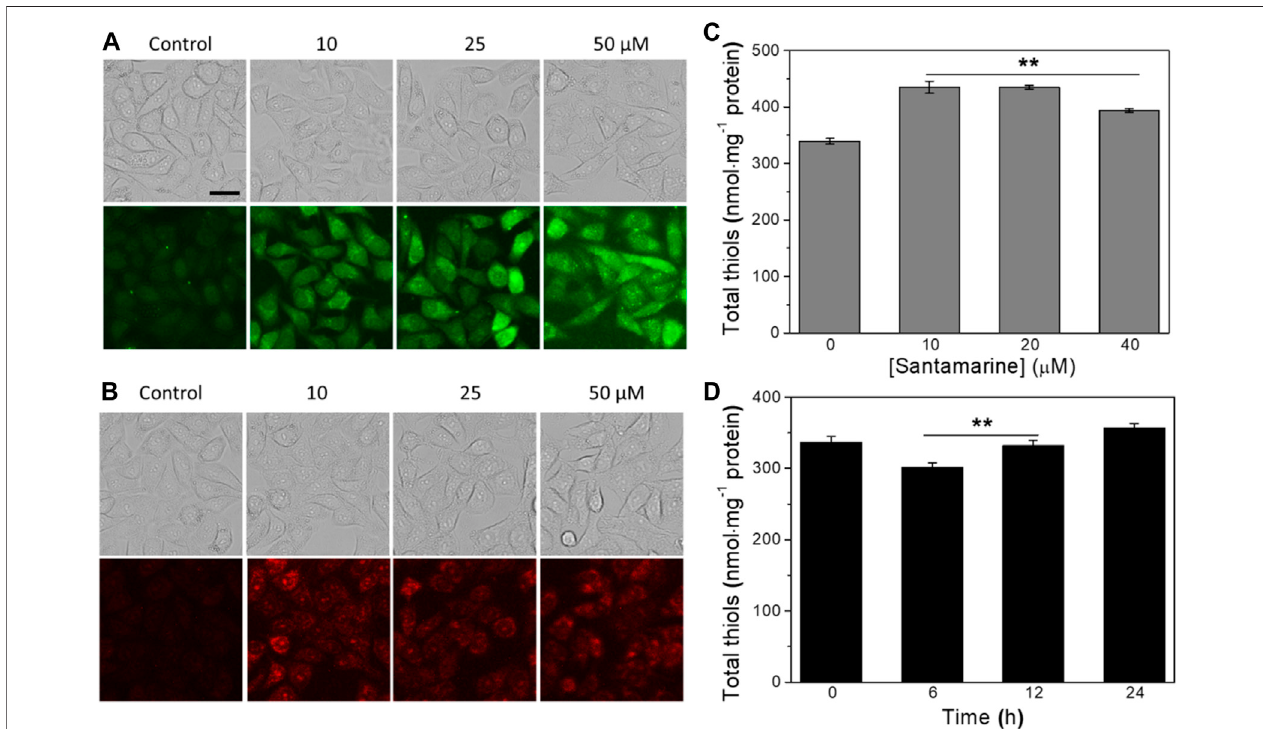
FIGURE 5 | Santamarine induces ROS and regulates the cellular stress response. (A) The intracellular ROS accumulation was determined by DCFH-DA staining. (B) The intracellular superoxide anion accumulation was determined by DHE staining. After treating HeLa cells with vehicle (control) or santamarine at indicated concentrations for 6 h, they were stained with DCFH-DA (10 μ M) and DHE (10 μ M) for 30 min, respectively, and analyzed by fl uorescence microscope to obtain phase contrast (top) and fl uorescence (bottom) images. The images represent three independent experiments performed in triplicate. Scale bar (cid:2) 20 μ m. (C) The intracellular total thiol homeostasis responded to an increasing concentration of santamarine treatment. (D) The intracellular total thiol homeostasis responded to different times of a fi xed concentration ofsantamarine treatment. Afterthe increasing concentrationsof santamarine (10, 20, or 40 μ M) were exposed totreat HeLa cells for 24 h, or 50 μ M of santamarine was exposed to treat HeLa cells for an indicated time (6, 12, or 24 h), the total thiol level in cell lysis was used DTNB titration determination. All data were from three independent experiments in triplicate. ** p < 0.01 vs. the control group in (C) , the 24 h group in (D)